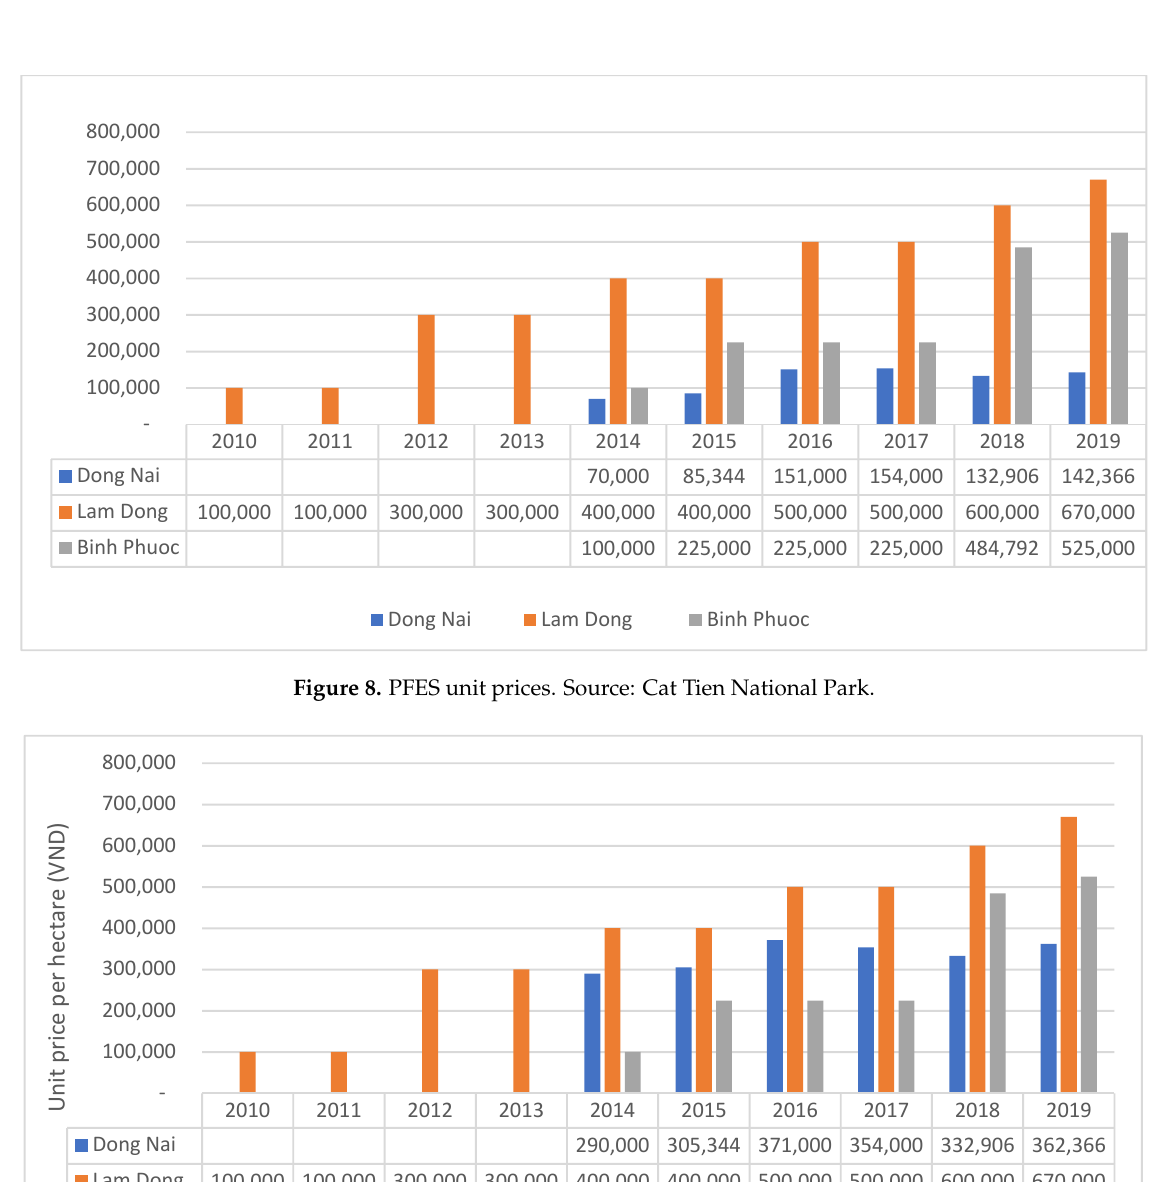
For households identified as better-off based on village-defined criteria, PFES ac- counts for 20% (Village A) to 50% (Village G) of total household income. Figure 10 shows